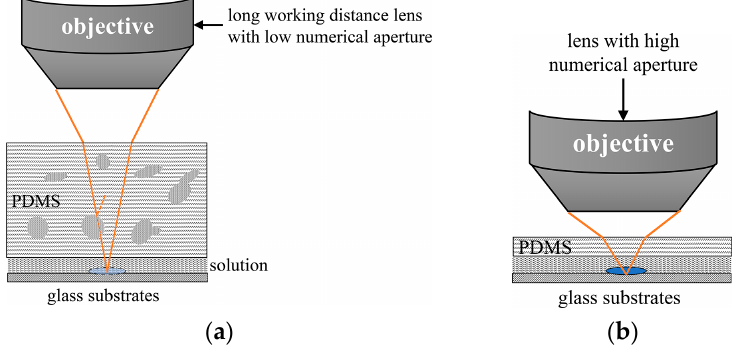
Figure 1. The scheme illustration of microscopic examinations: ( a ) observation of the particles in thick polydimethylsiloxane (PDMS)-based microfluidics; ( b ) observation of the particles in PDMS-based microfluidics with thin observation interface via the object of high numerical aperture.